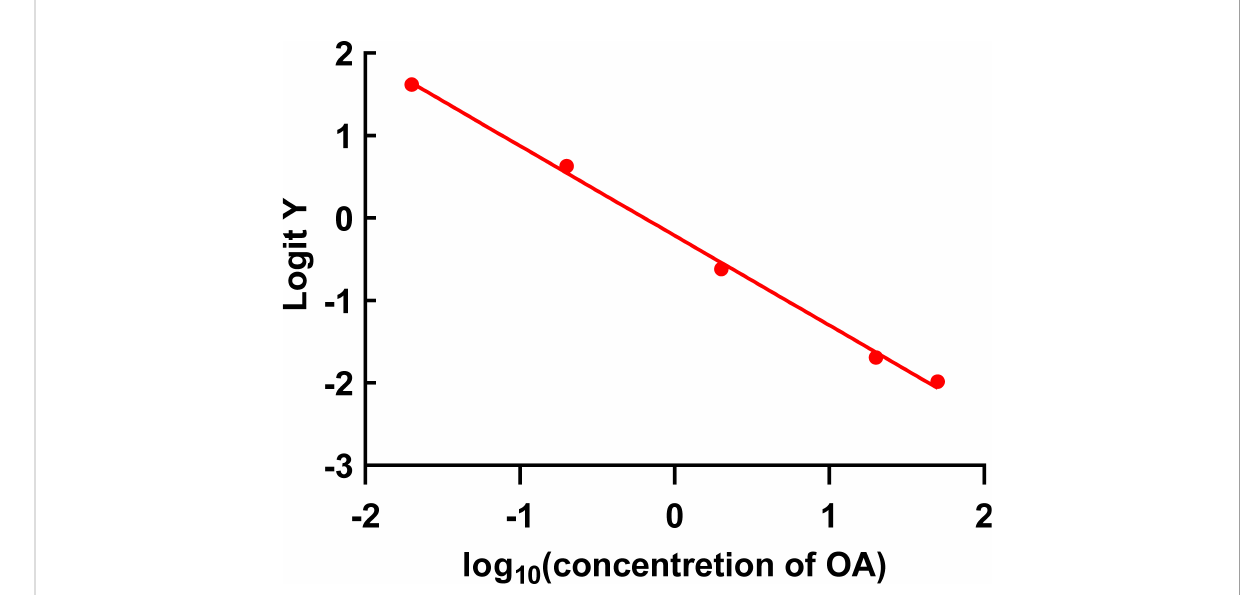
FIGURE 3 Standard curve of OA-TRFIA (the concentrations of OA were 0, 0.02, 0.2, 2, 20, and 50 ng/ml).